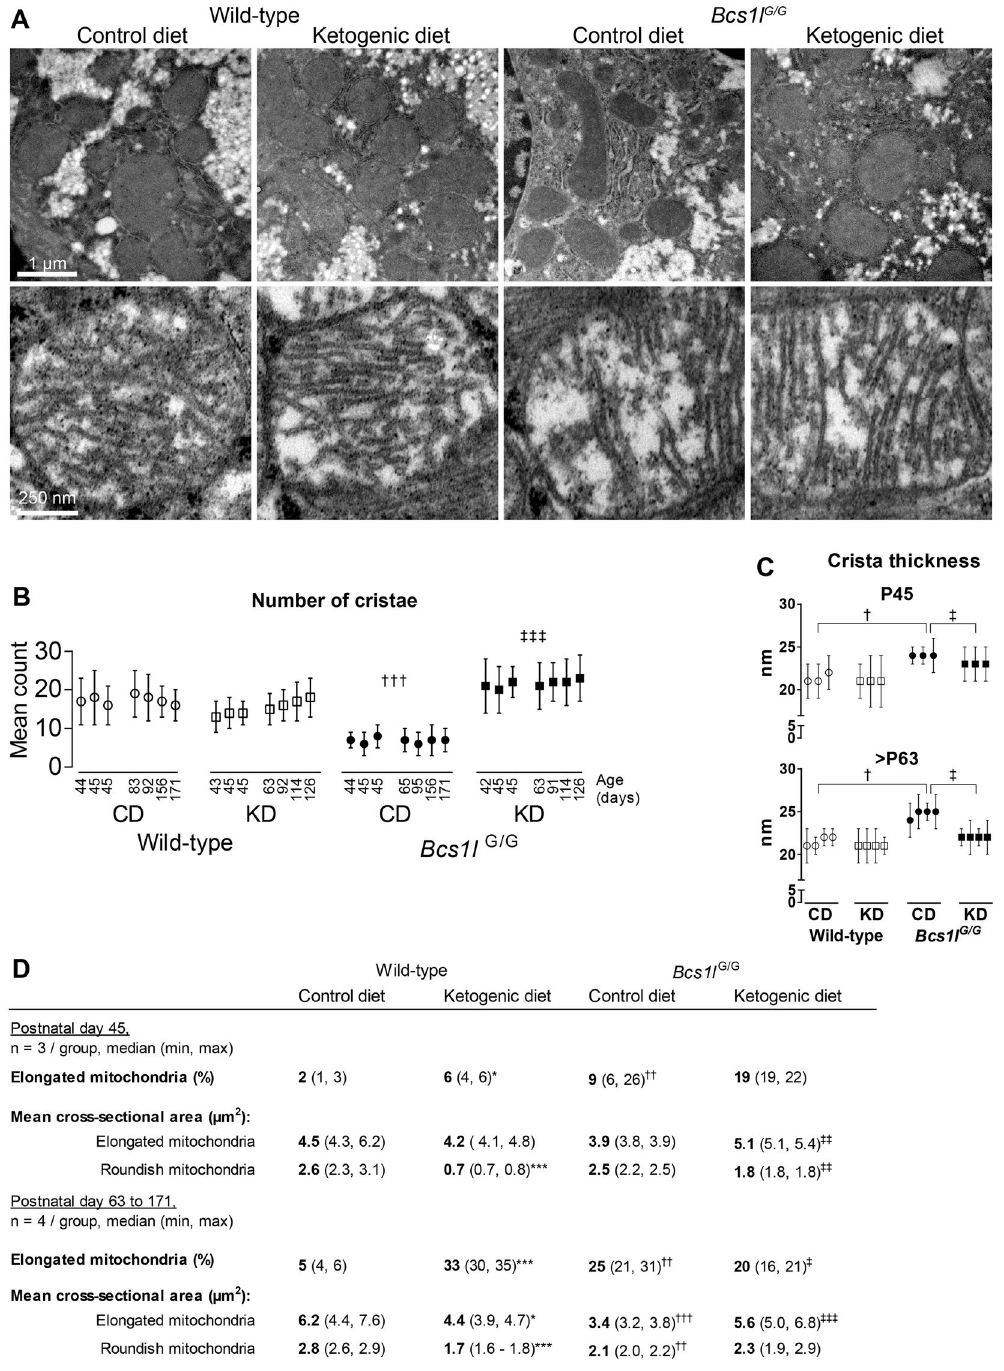
Figure 3. Ultrastructure of hepatocyte mitochondria is modulated by the Bcs1l mutation and the diet. ( A ) Upper row of representative electron micrographs shows general mitochondrial morphology in hepatocytes and lower panel typical cristae morphology and number of cristae in wild-type and Bcs1l G/G mice on CD and KD. ( B-C ) Mean mitochondrion cristae number and thickness. The data points represent five hundred mitochondria per mouse (mean ± SD). ( D ) Quantification of elongated and roundish mitochondria. Statistics: 1-way ANOVA followed by planned comparisons for all parameters except for cristae thickness for which Kruskal-Wallis test followed by Mann-Whitney U-tests was used. p < 0.05, p < 0.01, p < 0.001 ( * , ** and *** vs WT CD), ( † , †† and ††† vs WT CD), ( ‡ , ‡‡ and ‡‡‡ vs Bcs1l G/G